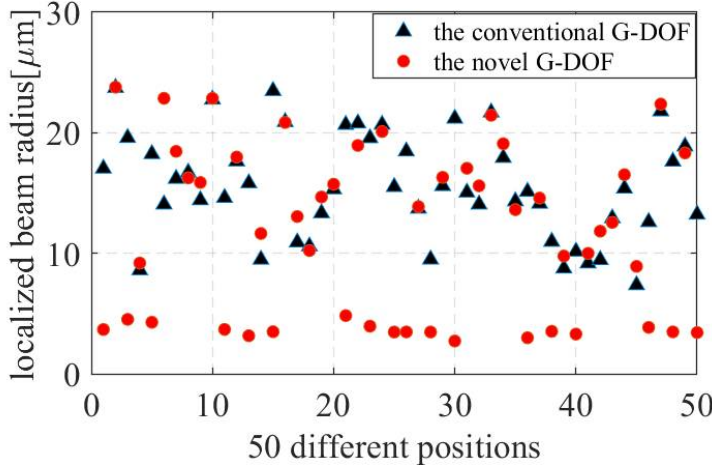
Figure 6. The localized beam radius at 50 different positions on the cross-section of both conven- tional G-DOF and novel G-DOF.